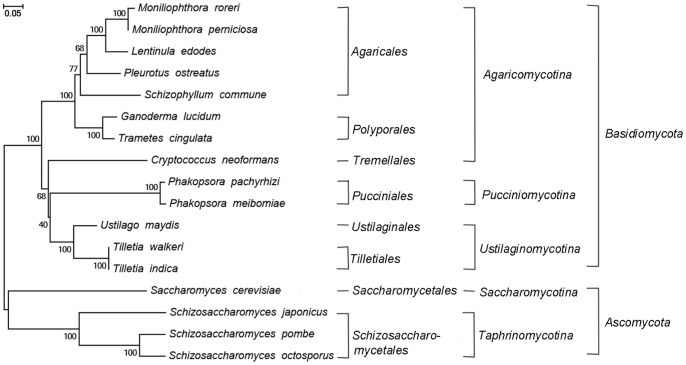
Molecular phylogenetic analysis.Amino acid sequences of the genes atp6, atp8, atp9, cob, cox1, and cox2 in Ganoderma lucidum and other 16 fungal species were used to construct this tree with the maximum likelihood method implemented in the software MEGA 5.05. The order, sub-kingdom, and kingdom corresponding to each species show their taxonomic classifications. Bootstrap supports were calculated from 1000 replicates.